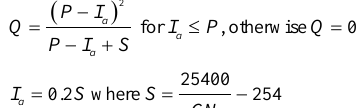
adjustments of model parameters (except the CN) until the simulated discharge acceptably match the measured discharge data (Santillan et al., 2011). The Nash-Sutcliffe Coefficient of Model Efficiency (NSE), percentage bias (PBIAS), and the RMSE-observations Standard Deviation Ratio (RSR) were used to evaluate the performance of the hydrologic model based on